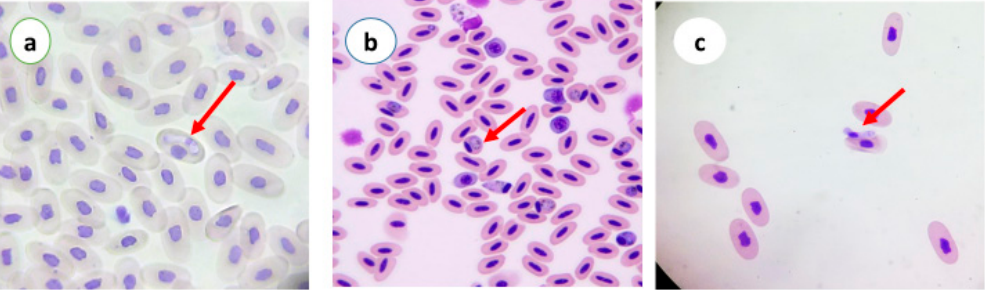
Figure 3. Blood smears of pigeon stained with Giemsa: ( a ) Haemoproteus ( ×1000); ( b ) Plasmodium (×400); and ( c ) Leucocytozoon (×400).